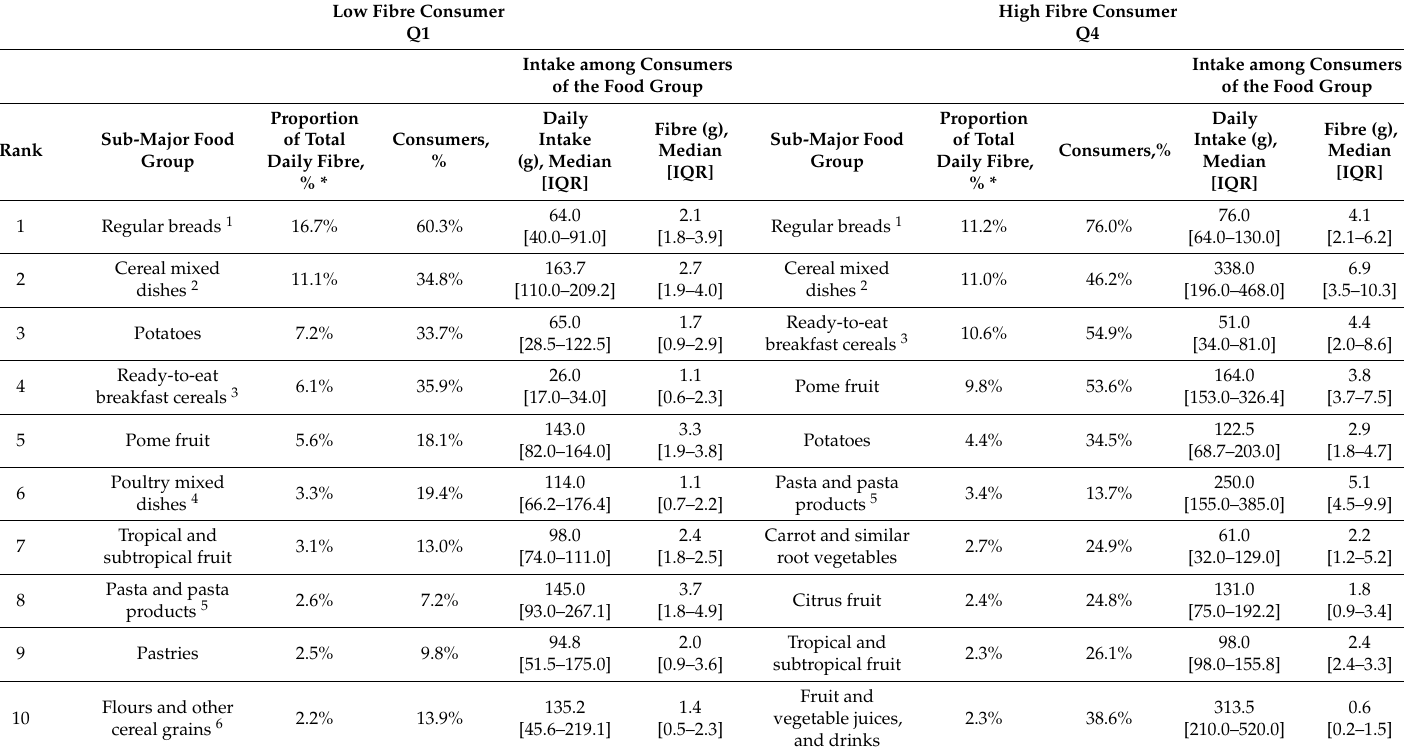
Table 3. Leading sub-major food groups by contribution to dietary fibre intake in children aged 2–18